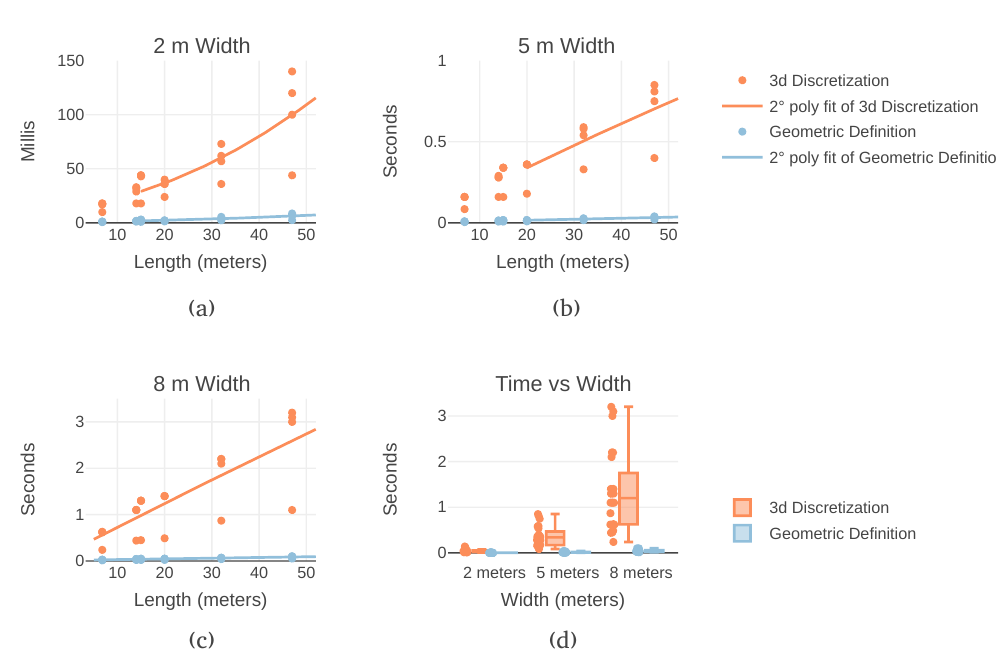
Figure 5. Obstacle avoidance times for varying flight corridor lengths and widths from experimental data with 0.5 m resolution. Avoidance time measures the processing time needed to cast all the rays that cover a flight corridor. Different flight corridor lengths (distance between start and end locations) and widths (safety margin) are shown. ( a ) The flight corridor measures two meters in width. ( b ) The flight corridor measures five meters in width. ( c ) The flight corridor measures eight meters in width. ( d ) Presentation of the results in the same scale to illustrate the magnitude of the variation in computation time of the two approaches and the influence of the flight corridor